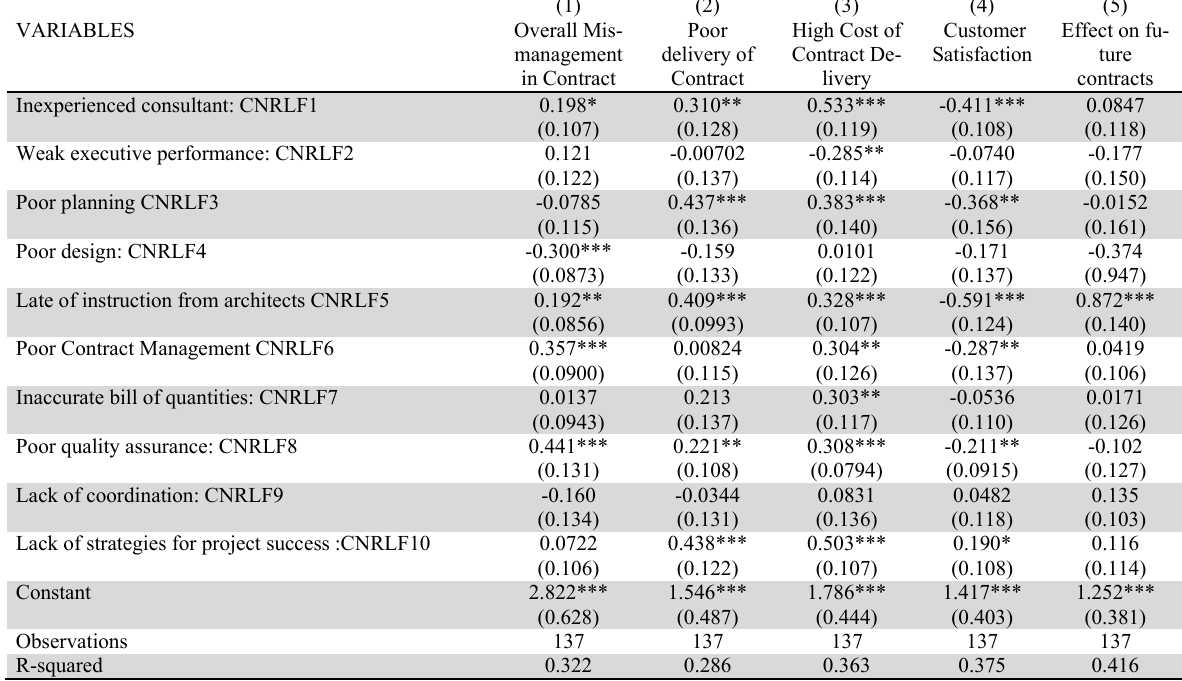
Consultant Related Factors for contract